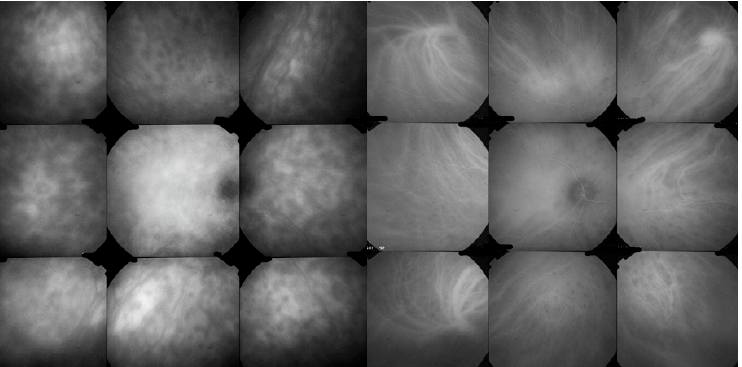
Figure 10. ICGA signs in BRC. Numerous HDDs in the pre-treatment panorama ( left ) that have disappeared after introducing immunosuppressive therapy ( right panorama).